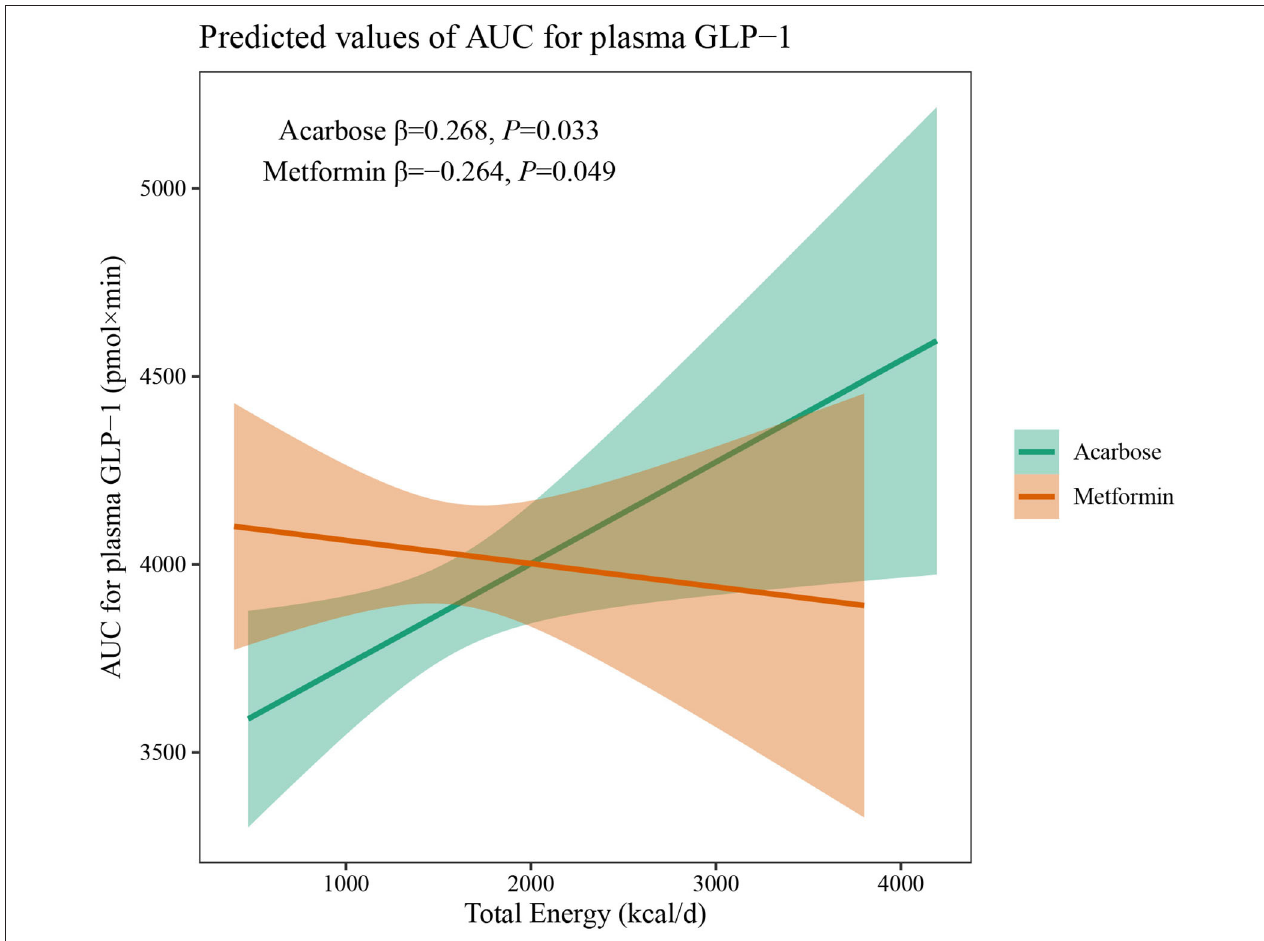
FIGURE 4 | Differential associations between total energy intake and AUC for plasma GLP-1 in metformin and acarbose groups. The β value adjusted for age, sex, time of intervention, and duration of